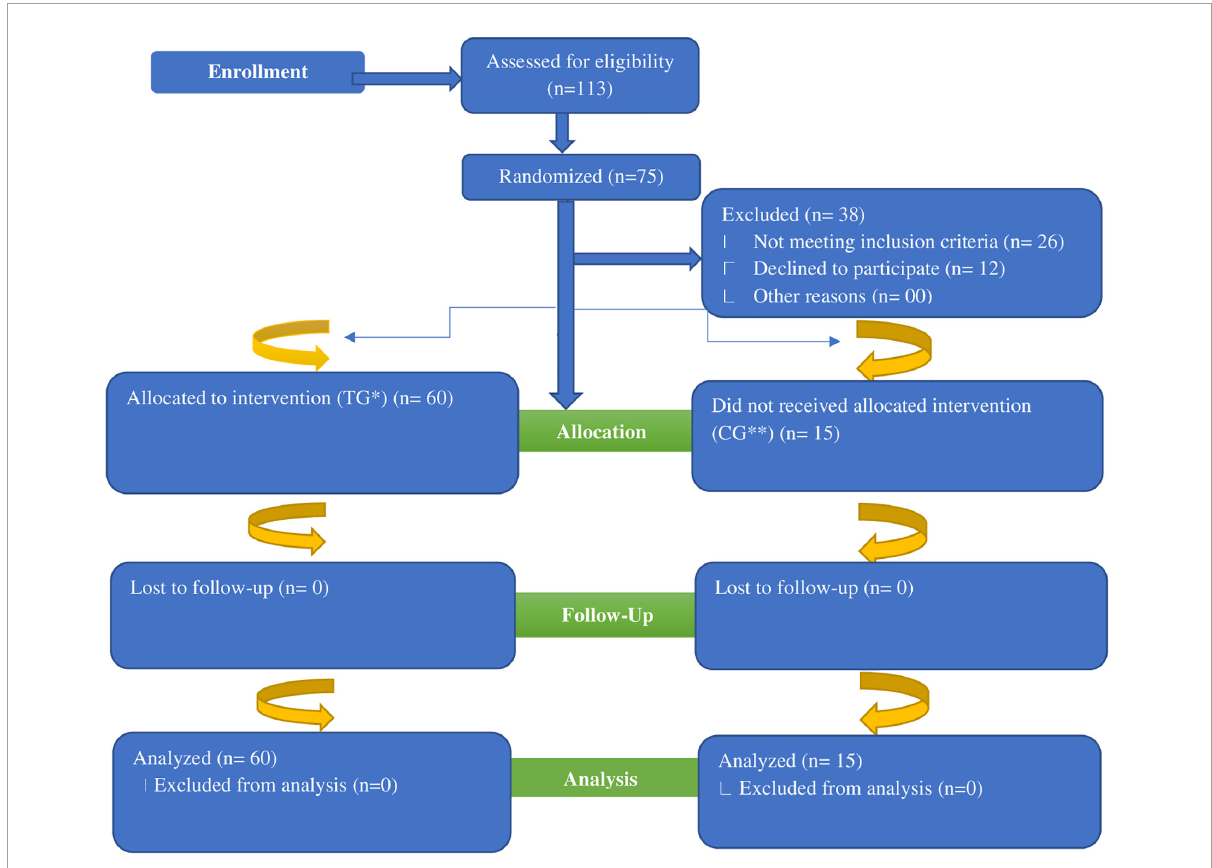
FIGURE1 Flow diagram of women subjects through the randomized controlled trial. ∗ TG, Treatment Group; ∗∗ CG, Control Group.